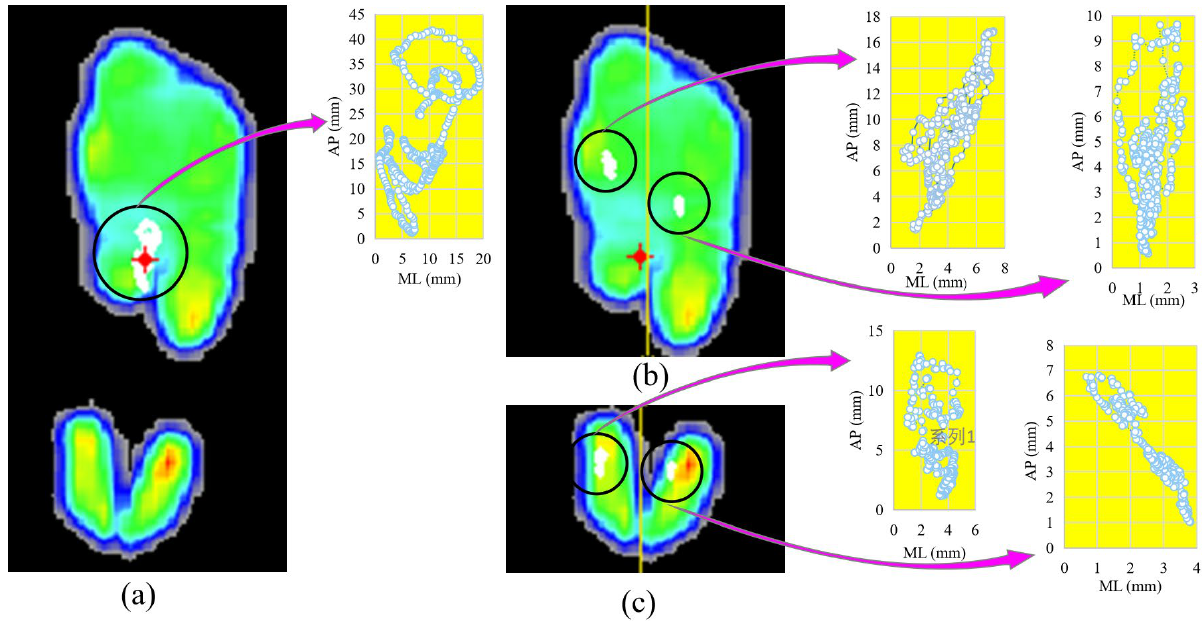
Figure 2. One example of the center of pressure (CoP) of planter and its sub-regions while standing on the dominant leg with eyes opened, before fatigue. ( a ) The maximum-pressure image and the sway of CoP; ( b ) the top of plantar is divided into two sub-regions along the yellow line, and the sway of CoP; ( c ) the bottom of plantar is divided to two sub-regions along the yellow line, and the sway of CoP of plantar and sub-regions.